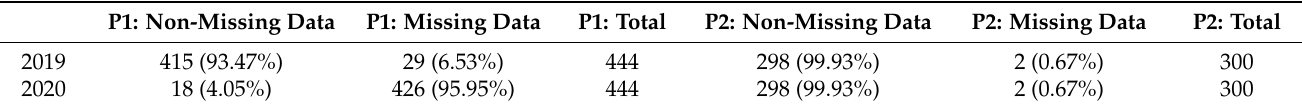
Table 4. December 2019 vs. December 2020: missing data and non-missing data. P1: From 0:00 on 1